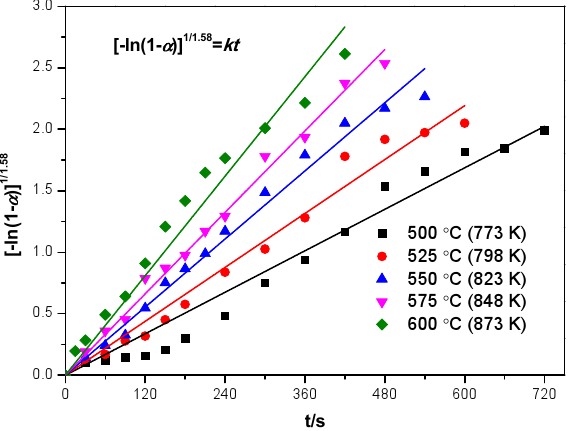
Table 2. Parameters of Equation (5) for the selected process temperatures.